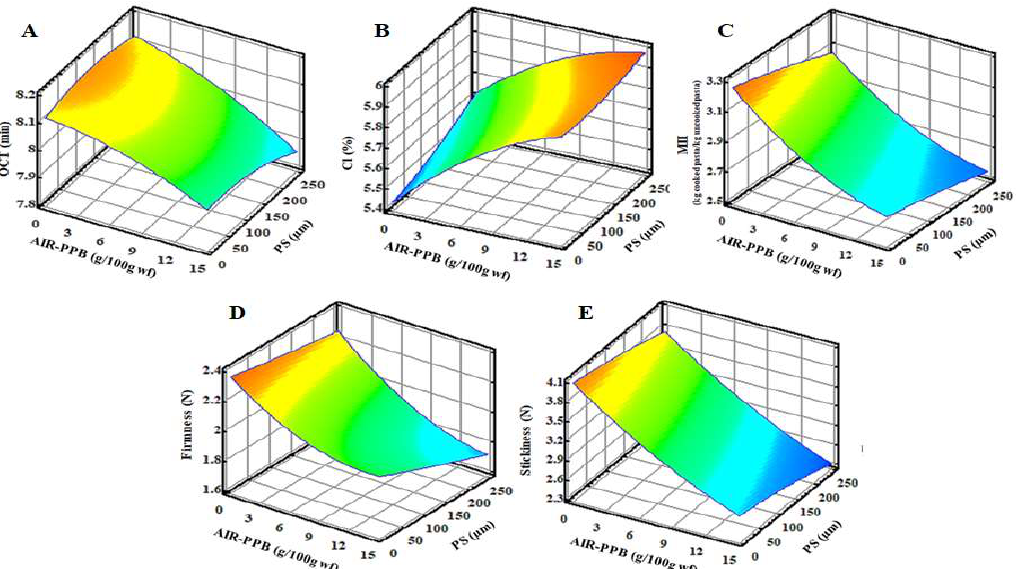
ature (°C), Tc: conclusion temperature (°C) and H : enthalpy value.